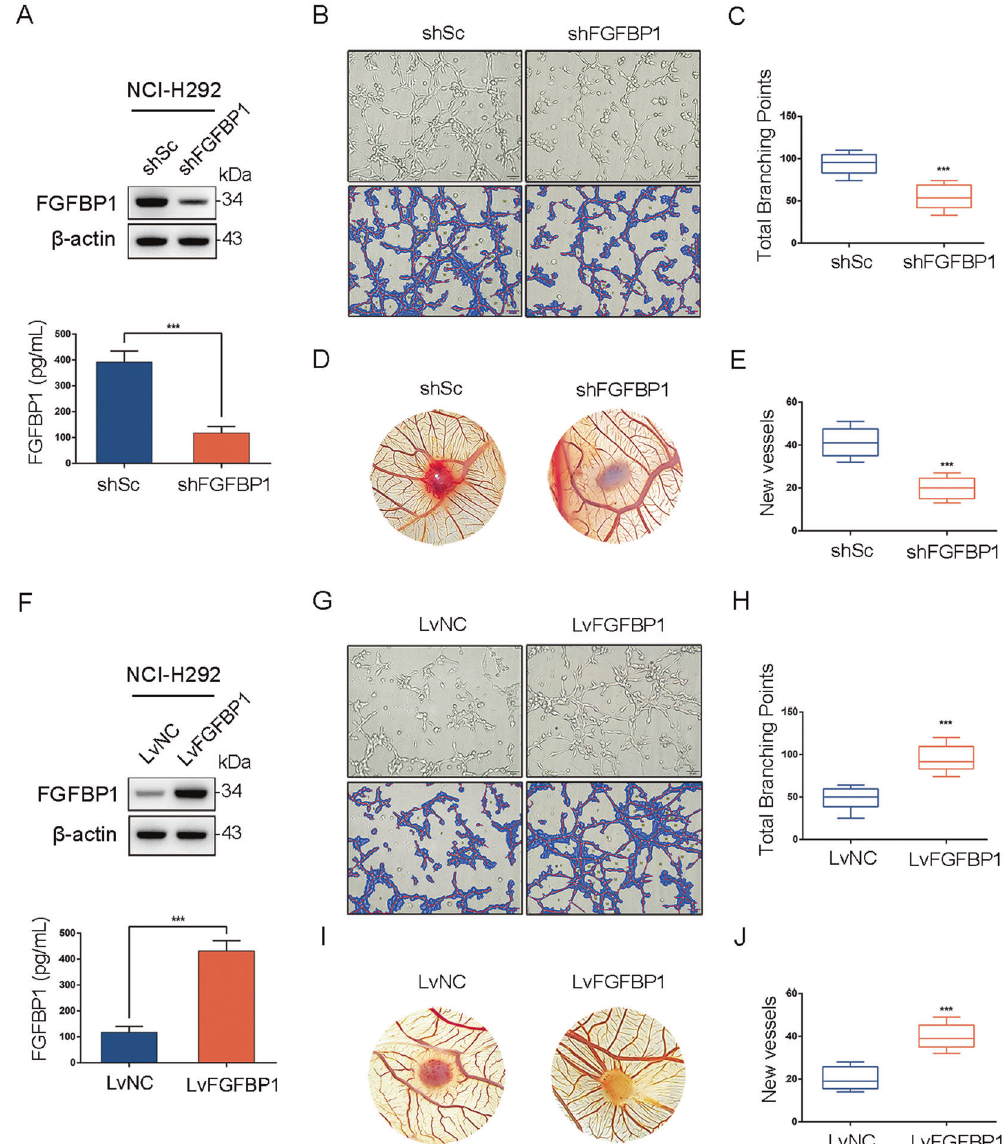
Fig. 7 PLA promotes angiogenesis through FGFBP1. A NCI-H292 cells, stably expressed shRNA targeting FGFBP1 (shFGFBP1) or a control shRNA (shSc), were treated with 20 μ g/mL PLA for 24 h. Western blot (upper panel) and ELISA (lower panel) were performed to detect the protein levels of FGFBP1 in cell lysates and supernatants, respectively. B – E NCI-H292/shFGFBP1 and NCI-H292/shSc cells were treated with PLA (20 μ g/mL) for 24 h and the cell-conditioned media were collected for tube formation assay ( B , C ) and CAM assay ( D , E ). B , D Representative micrographs of tube formation assay ( B ) and CAM assay ( D ). C , E Quantitations of total branching points of tube formation assay ( C ) and new vessels of CAM assay ( E ). F NCI-H292 cells infected with lentivirus harboring a vector encoding FGFBP1 (LvFGFBP1) or the empty vector (LvNC). Western blot (upper panel) and ELISA (lower panel) were performed to detect the protein levels of FGFBP1 in cell lysates and supernatants, respectively. ( G – J ) The cell-conditioned media of NCI-H292/LvFGFBP1 and NCI-H292/LvNC cells were collected for tube formation assay ( G , H ) and CAM assay ( I , J ). G , I Representative micrographs of tube formation assay ( G ) and CAM assay ( I ). H , J Quantitation of total branching points of tube formation assay ( H ) and new vessels of CAM assay ( J ). n = 6 chick embryos per group. Results are shown as mean ± SD. *** P <